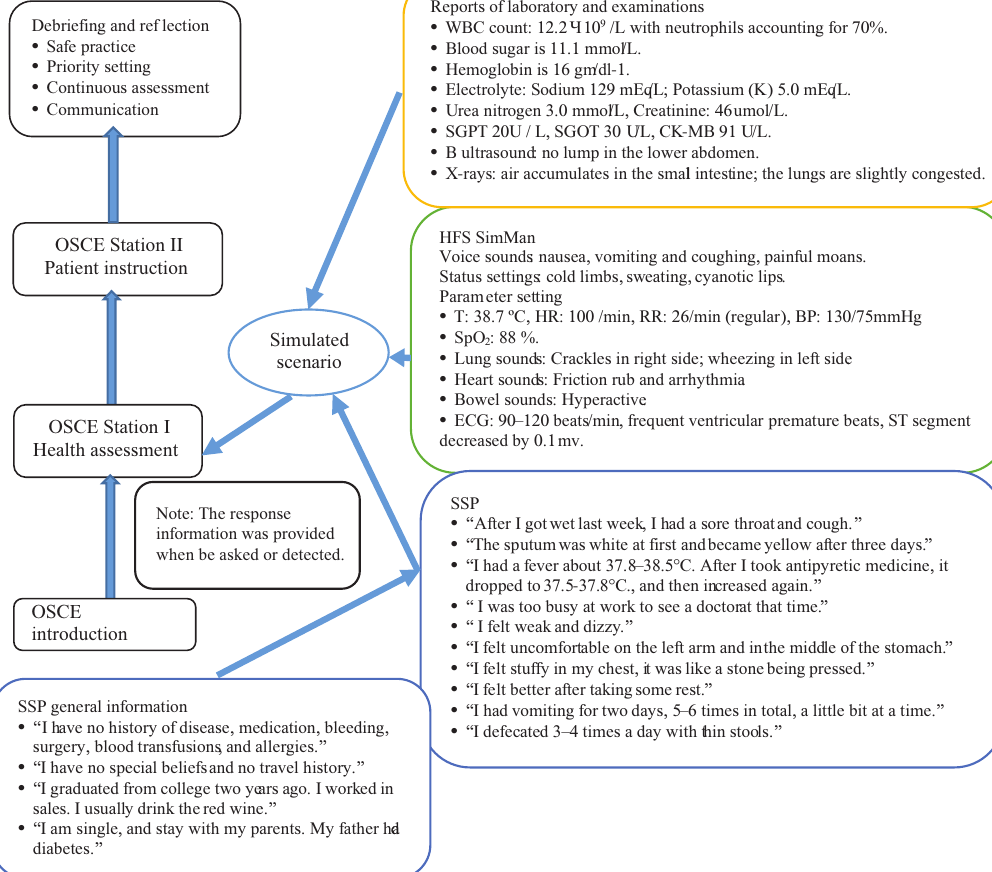
Figure 1. The simulated scenario for OSCE. OSCE, objective structured clinical